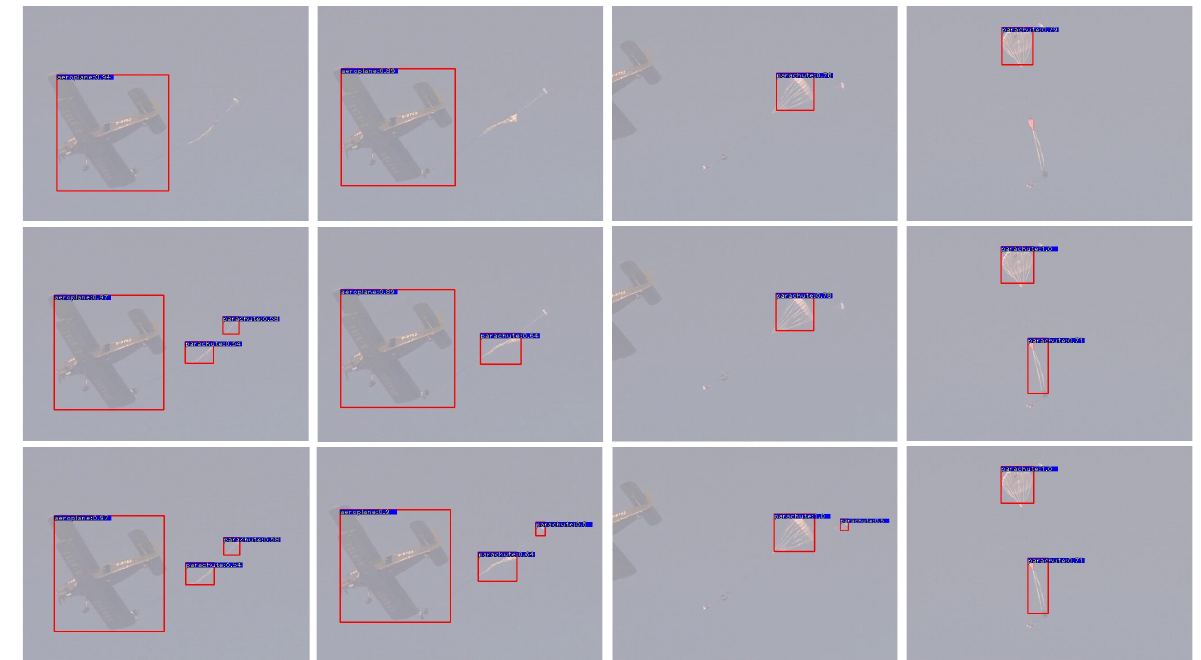
Figure 13. Comparison between our detector and the original RetinaNet. From the first row to the last row, the detection results of the original RetinaNet, the RetinaNet with the CBAF module, and the RetinaNet with the ODEM-GAN module are represented, respectively.